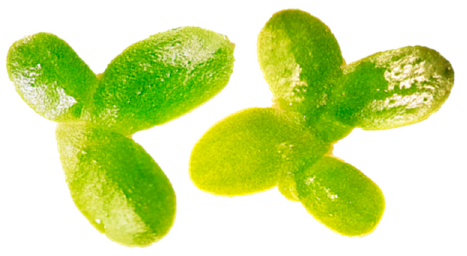
Figure 9. Example of duckweed species recommended for ecotoxicity assessment by standard guidelines: Lemna minor (common